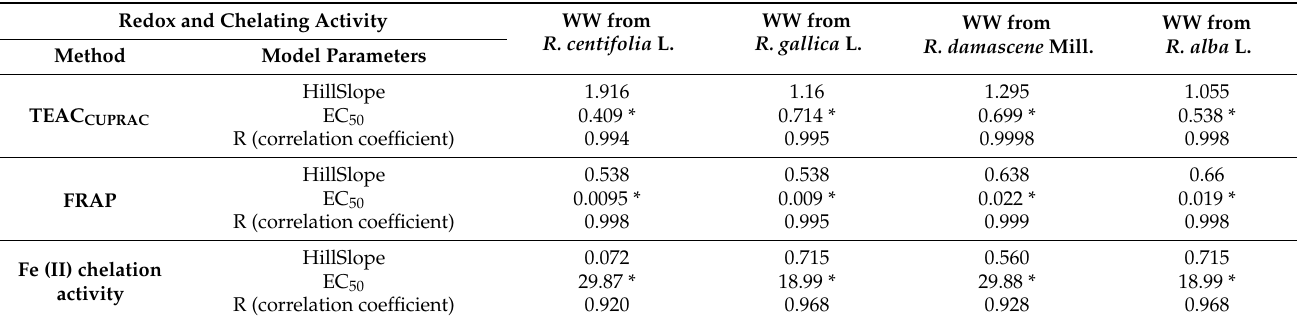
Table 5. Median effective concentration of redox ‐ modulating capacity of wastewaters from four different rose species, determined by Cu(I) ‐ and Fe(II) ‐ chelating and Fe(III) ‐ reducing activity.